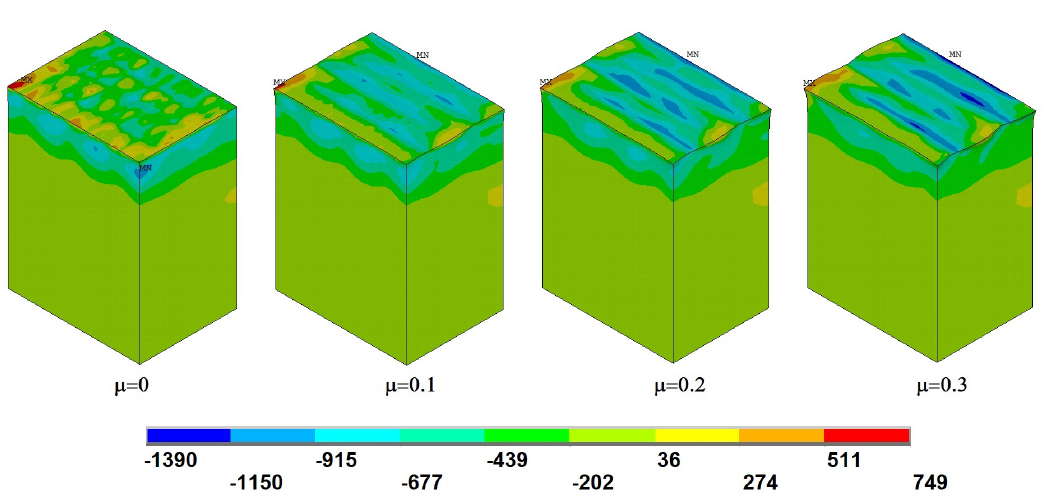
Figure 5. Deep residual stress (MPa) perpendicular to the burnishing direction ( σ z ) as the coefficient of friction increases.